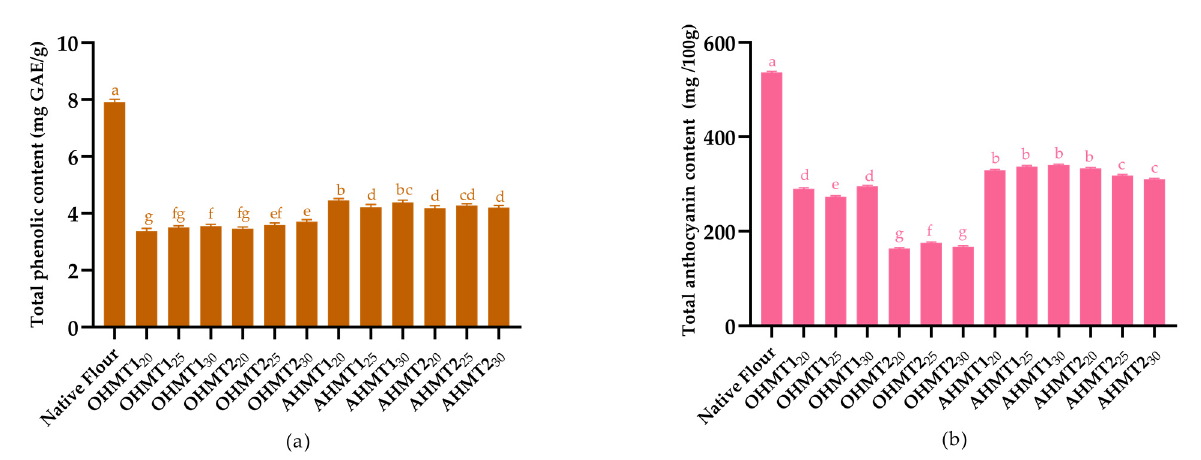
Figure 3. Bioactive compound of native and HMT-treated purple rice fl our samples. ( a ): total phenolic content, ( b ): total anthocyanin content. Means ± standard deviations from three replicate experiments. Different letters are considered significantly different according to Duncan’s multiple comparison test ( p ˂ 0.05).